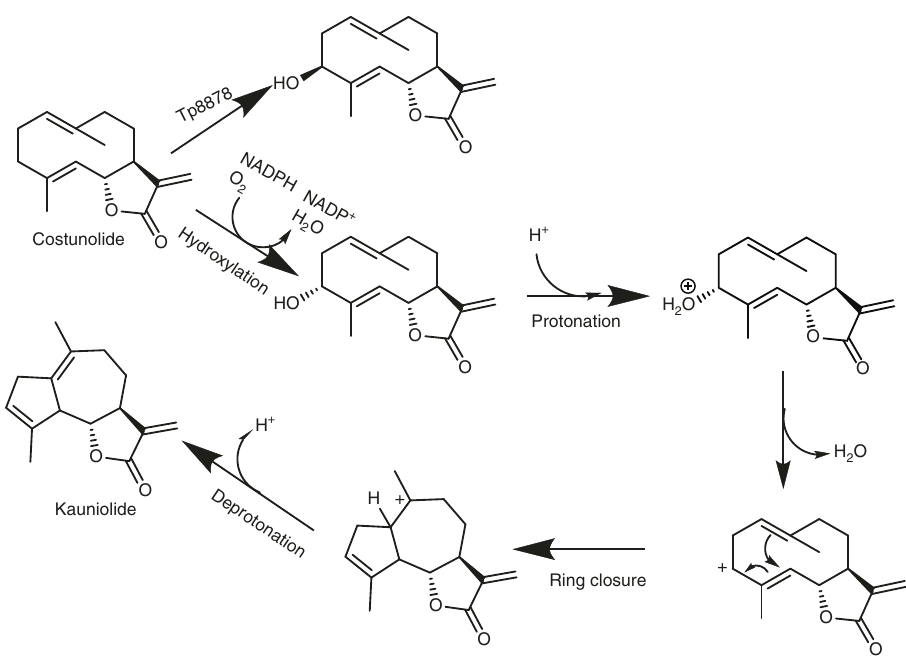
Fig. 7 Proposed mechanism of action of TpKLS. Costunolide is hydroxylated at the C3 position (in which the α -orientation is favoured). We postulate that C3 α -hydroxylation is followed by protonation and water abstraction resulting in an allylic carbocation. The C5 carbocation resonance form is attacked by the C1 – C10 double bond which results in C1 – C5 ring closure. Subsequent deprotonation results in kauniolide. Note that proposed protonation has not been proven in this